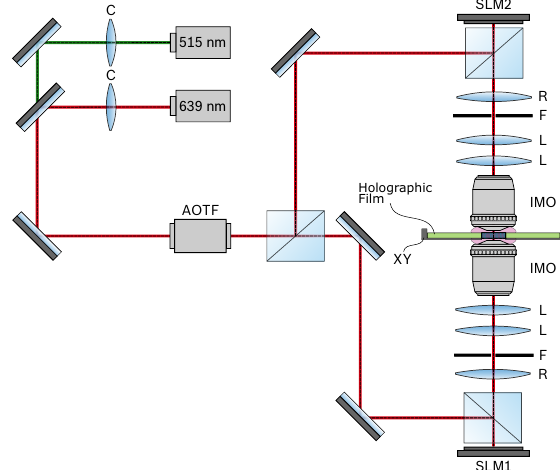
Figure 2. Schematic representation of the employed holographic wave front printer setup. Two laser-based optical sources are collimated (C), aligned on a common optical axis and tuned by an AOTF before being evenly split up and relayed onto two SLMs (SLM1, SLM2), which shape the wave fronts according to the recording configuration. The resulting wave fronts are traversing two symmetrical optical systems, each containing multiple achromatic relay lenses (R, L), a spatial filter (F) and an immersion-based microscope objective (IMO). Both recording wave fronts interfere in a plane of holographic film, positioned by a high-precision two-dimensional translation stage